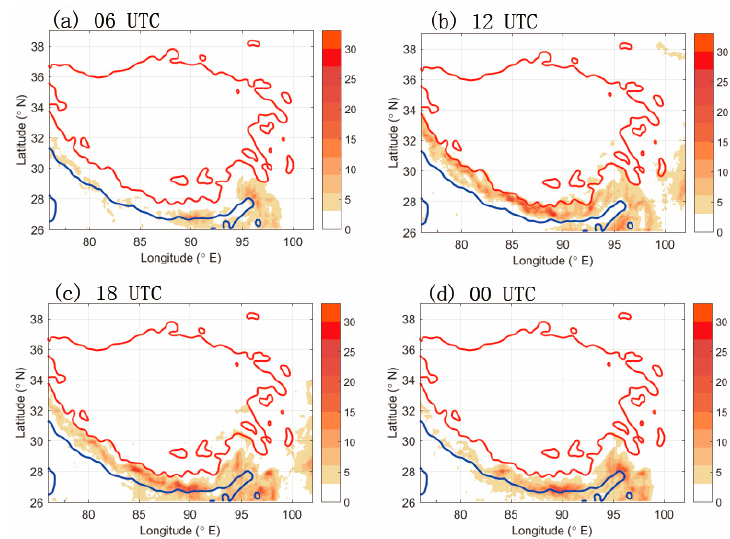
Figure 3. 6-h accumulated rainfall (shading: shaded region shows rainfall greater than 3 mm / 6 h; Figure 3. 6 − h accumulated rainfall (shading: shaded region shows rainfall greater than 3 mm/6h; contour interval is 3 mm / 6 h) averaged over the 3-month period at ( a ) 06 UTC, ( b ) 12 UTC, ( c ) 18 UTC, contour interval is 3 mm/6 h) averaged over the 3 − month period at ( a ) 06 UTC, ( b ) 12 UTC, ( c ) 18 and ( d ) 00 UTC. Local time is UTC time plus 6 UTC, and ( d ) 00 UTC. Local time is UTC time plus 6 h.